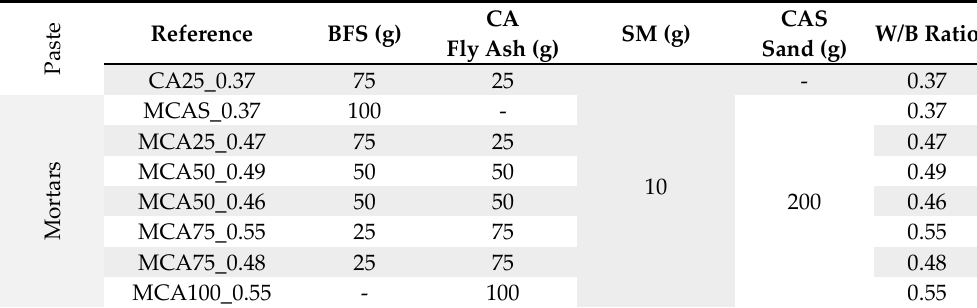
Table 2. Compositions of the prepared materials with residues from the CA boiler.